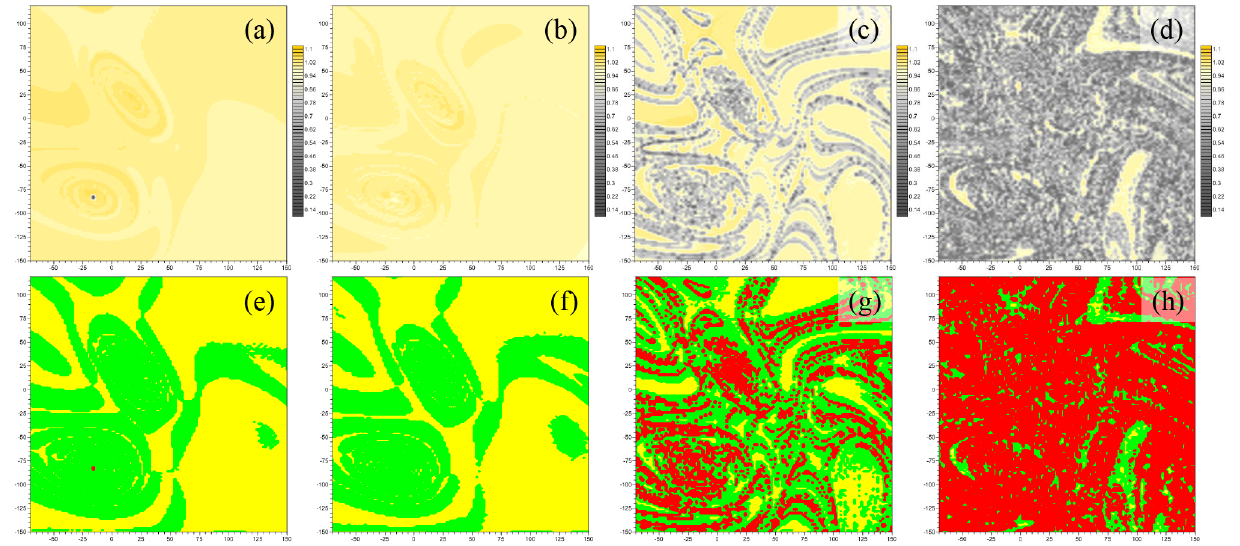
Figure 11. PBA diagnostics for γ = 1 . 1 and T p = 30 years, with ε = 0 , 0 . 05 , 0 . 1 and 0 . 2, respectively, for the two sets of four maps. Upper- row panels (a) – (d) show the field of (cid:50)(X,Y) in the ((cid:57) 1 ,(cid:57) 3 ) plane, as defined in Eq. (9); the color bar for the (cid:50)(X,Y) values is shown to the right of each panel, and it extends over the range [ 0 . 1 , 1 . 12 ] . Lower-row panels (e) – (h) show the field of (cid:56)(X,Y) in the ((cid:57) 1 ,(cid:57) 3 ) plane, as defined in Eq. 10, with the threshold value (cid:50) 0 = 0 . 8; here (cid:56) = 1 is colored yellow, (cid:56) =2 is green and (cid:56) = 3 is red. The corresponding maps of σ(X,Y) appear in Fig. 6e–h, respectively.